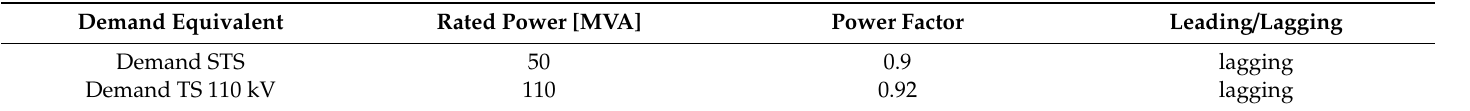
Table A6. Electrical parameters for the demand equivalents used in the